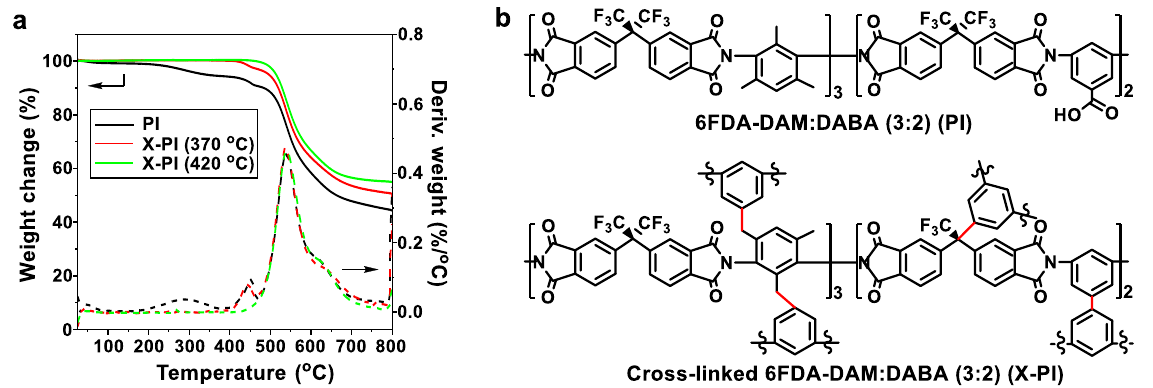
Figure 2. ( a ) TGA thermograms of free-standing 6FDA-DAM:DABA (3:2) (PI), X-PI (370), and X-PI (420), and ( b ) a possible chemical structure of the cross-linked PI in comparison with the chemical structure of